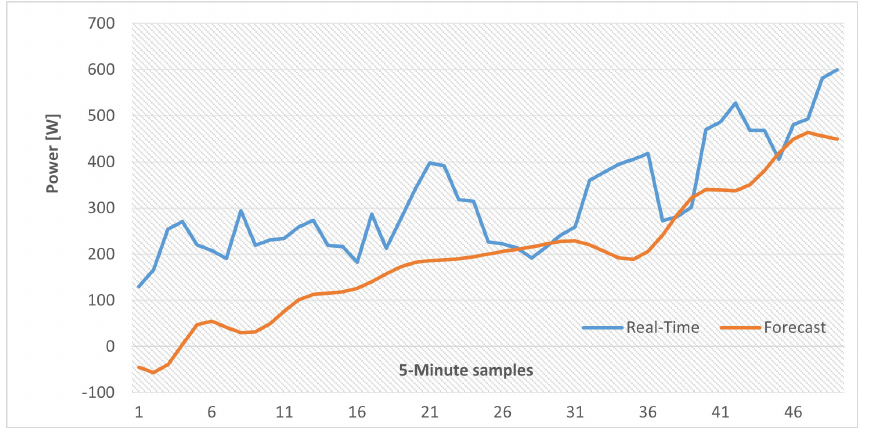
Figure 15. Internal power excess/deficit inside the MG (Four hour